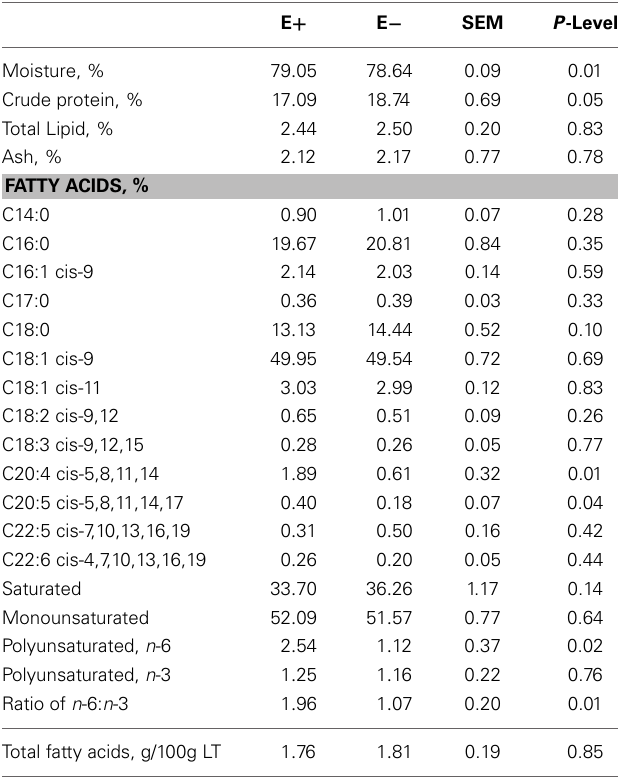
Table 2 | Effect of feeding tall fescue seed with endophyte (E + ) vs. endophyte-free (E − ) to ewes during gestation (d 35 to parturition) on lamb organ, muscle and adipose tissue weights.